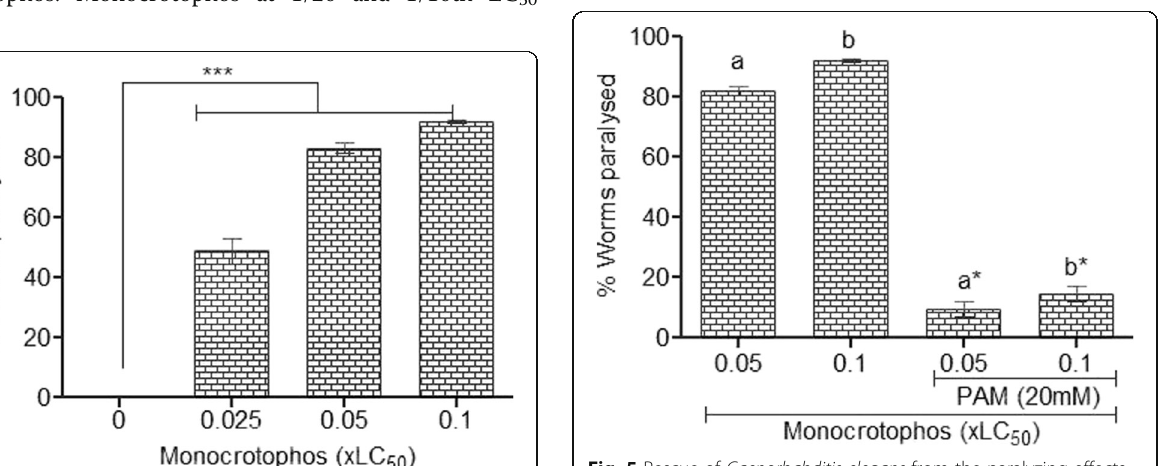
Fig. 5 Rescue of Caenorhabditis elegans from the paralyzing effects of monocrotophos by pralidoxime (PAM). Values are mean ± SE ( n = 9). p < 0.001 for a v/s a* and b v/s